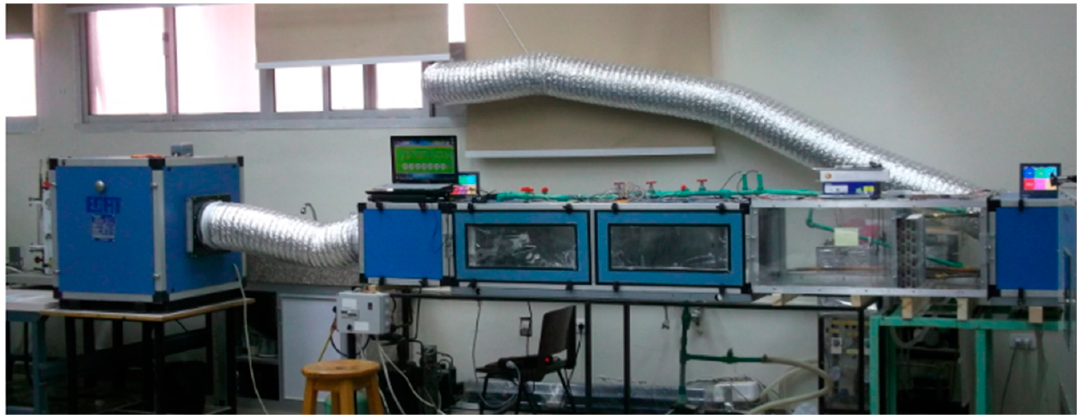
Figure 2. Experimental setup of the desalination system.